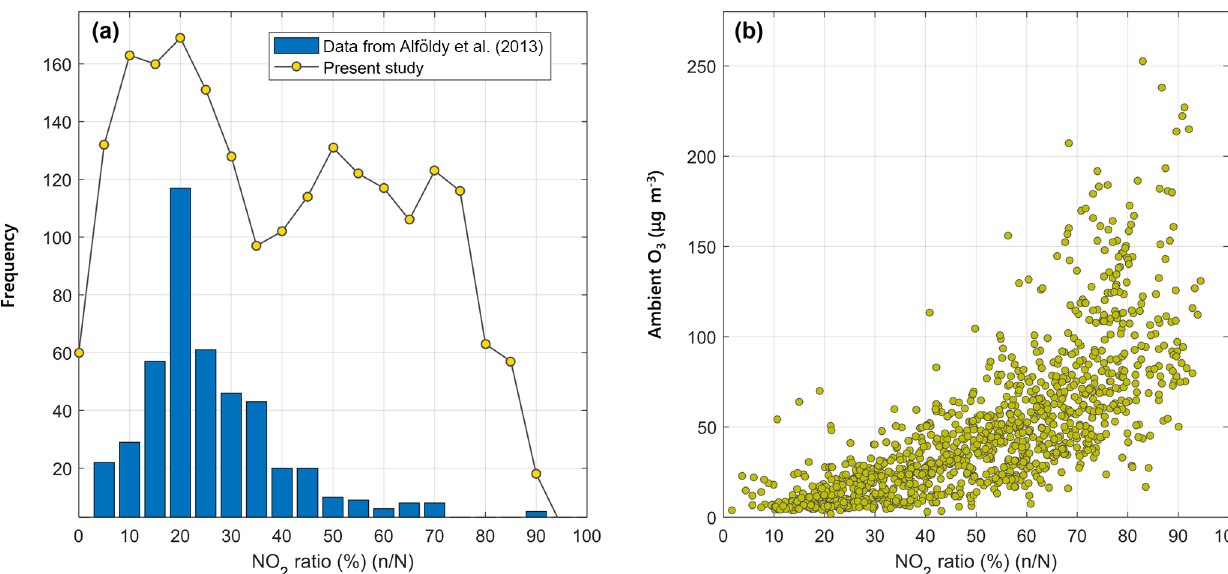
Figure 3. The NO 2 ratio distribution during plumes in this study and during a similar study (a) , and a plot of the NO 2 ratio against ambient O 3 concentrations during plume periods (b)